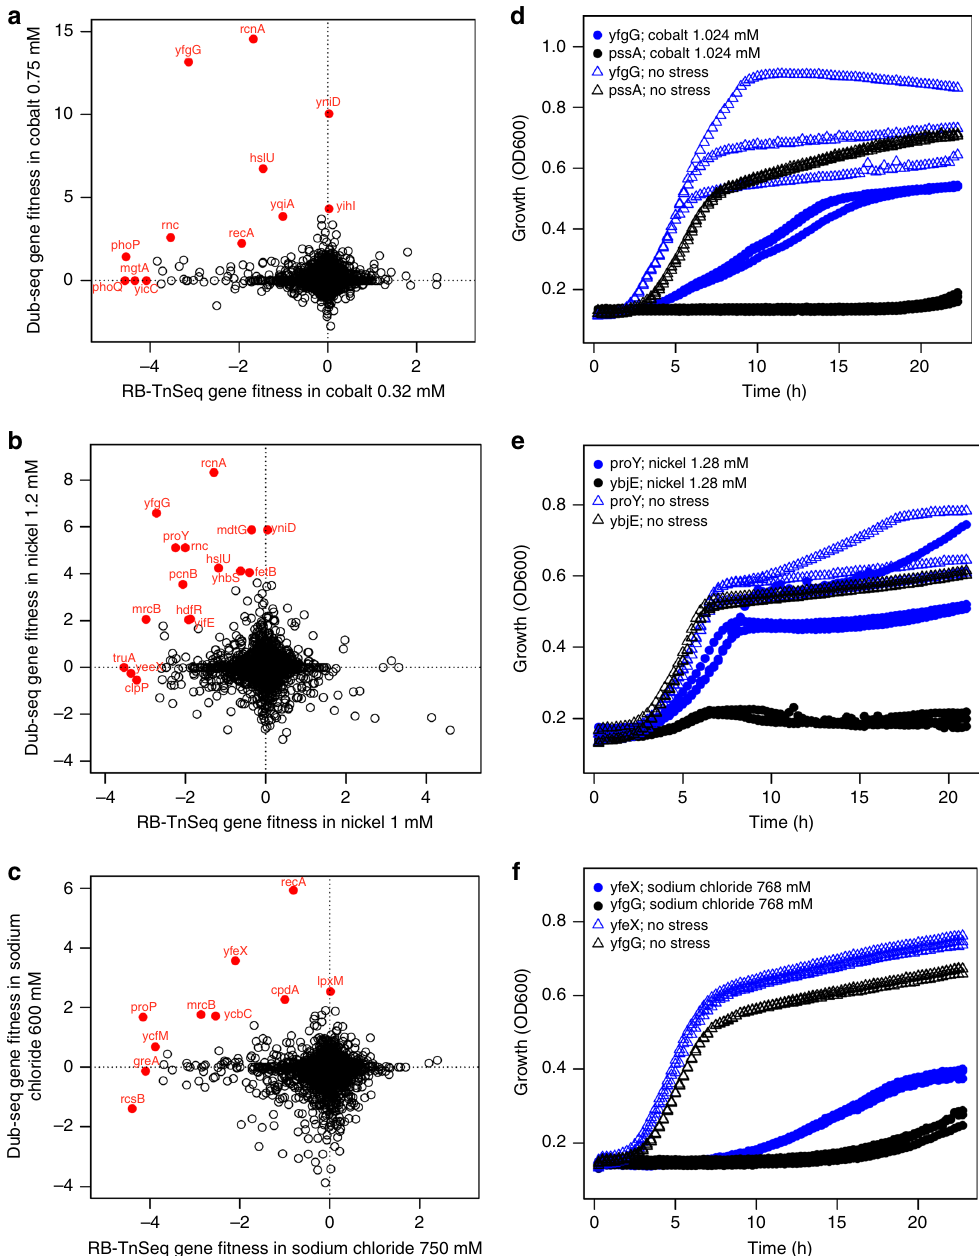
Fig. 5 Comparing genome-wide loss- and gain-of-function phenotype data. a – c Comparison of RB-TnSeq fi tness data 15 ( x axis) and dual-barcoded shotgun expression library sequencing (Dub-seq) gene fi tness data for E. coli genes under growth with inhibitory concentrations of cobalt ( a ), nickel ( b ), and sodium chloride ( c ). Selected genes are highlighted. d Growth of E. coli overexpressing yfgG under cobalt stress; pssA is a control. e Growth of E. coli overexpressing proY under nickel stress; ybjE is a control. f Growth of E. coli overexpressing yfeX under sodium chloride stress; yfgG is used as a control. Growth curves in ( d ), ( e ), and ( f ) are averaged from three replicate experiments. Source data are provided as a Source Data fi an important technology gap in performing gain-of-function screens and will facilitates systematic functional characterization of microbial genomes.